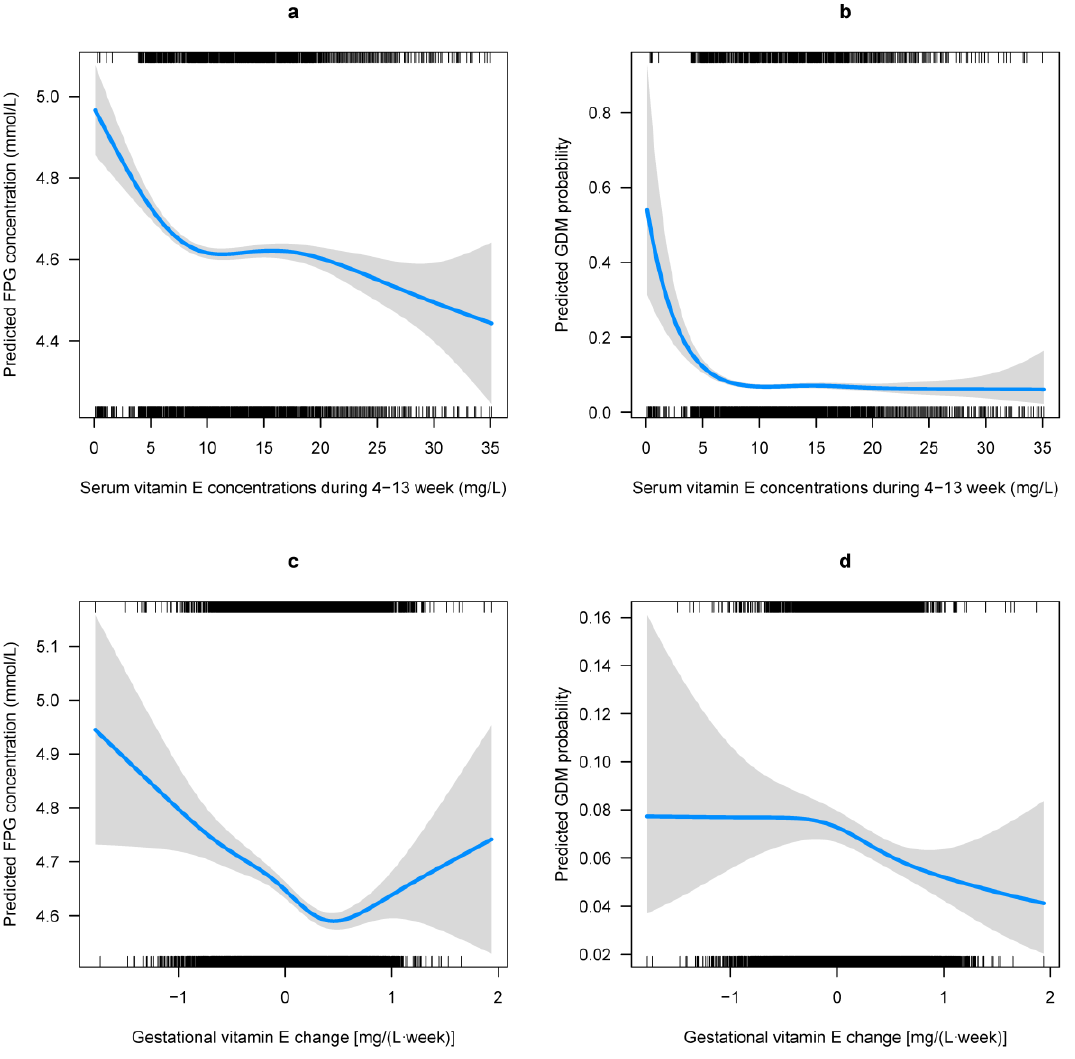
Figure 2. Predicted concentration of FPG and risk of GDM with respect to gestational vitamin E (VE) status. Predicted concentration of FPG and the 95% CIs were calculated with respect to ( a ) the first-trimester VE concentrations and ( c ) the gestational VE change by employing generalized additive models. Predicted risk of GDM and the 95% CIs were also calculated with respect to ( b ) the first-trimester VE concentrations and ( d ) the gestational VE change by employing generalized additive models. All models were adjusted for region, household registration, education, ethnic origin, age, ART, primigravida, pre pregnancy BMI, hypertension, and FPG levels at gestational age of 4–13 weeks, as well as the confounding of the first-trimester VE concentrations and the gestational VE change on each other.